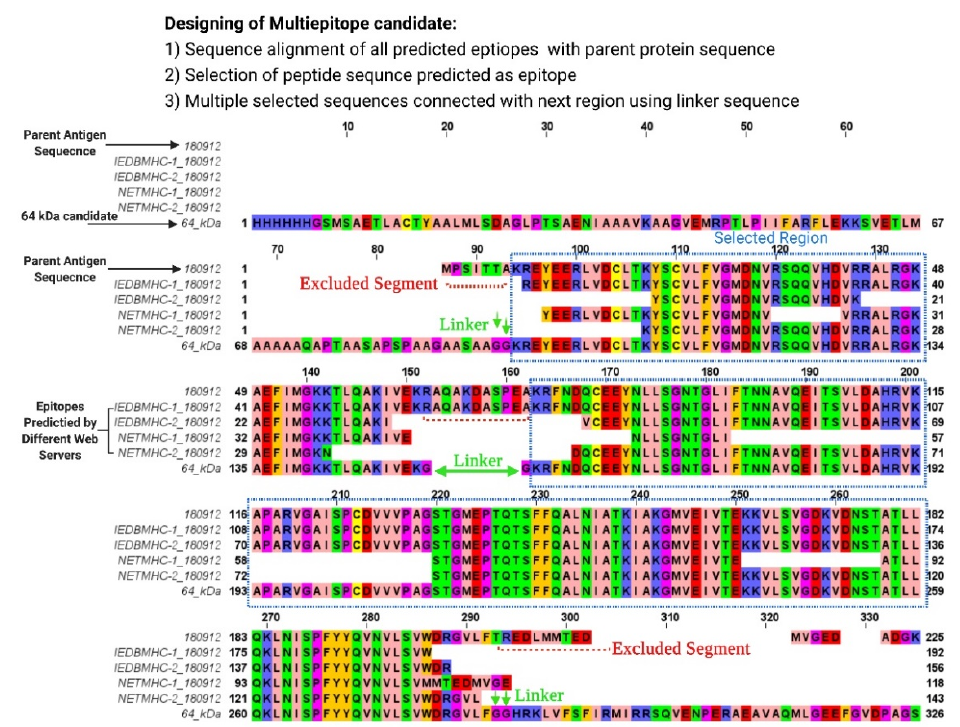
Figure 1. General scheme for epitope selection and designing of multiepitope construct using peptide regions identified as T cell epitopes by IEDB for MHC-I and MHC-II, NETMHC-1, and NETMHC-2. Representative image for epitope selection from F2/1 (AY-180912) for the 64 kDa construct. Sequence alignment by Clustal Omega (EMBL-EBI). Details are available in the Supplementary Materials. Table 1. M ultiple overlaying regions of epitopes used in designing the multiepitope constructs.